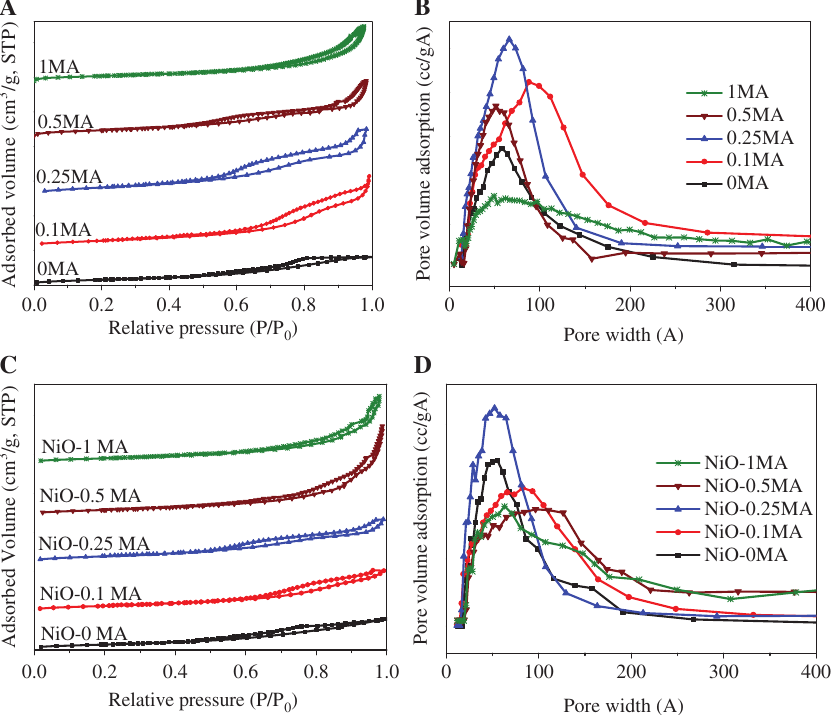
adsorption-desorption isotherms and pore size distribution of the xMA supports (A, B) and NiO-xMA catalysts (C, D). Figure 1: N 2